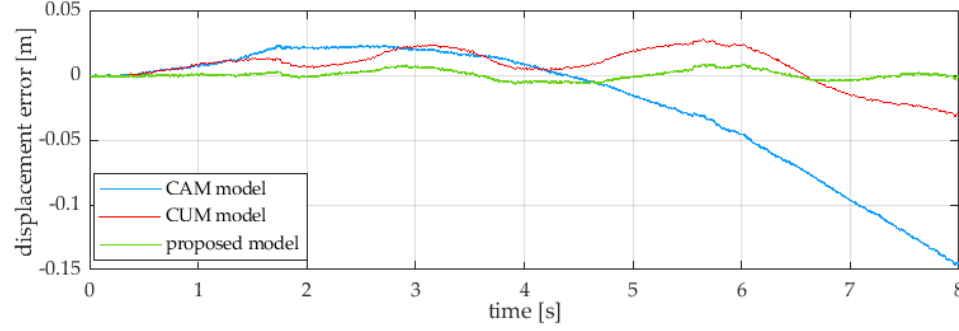
Figure 7. Ball velocity as a function of time and comparison of waveforms from experimental data and numerical models. Figure 8. Absolute errors of ball velocity as a function of time for the considered numerical models. In order to better systematize the obtained results, quality indicators were addi- tionally determined regarding the absolute errors of displacement   and velocity   . These indicators were calculated as integrals:   =  |  ()|   , (20)   =  |  ()|   . (21) A summary of the obtained values for the adopted quality indicators of model convergence and maximum errors is presented in Table 2.